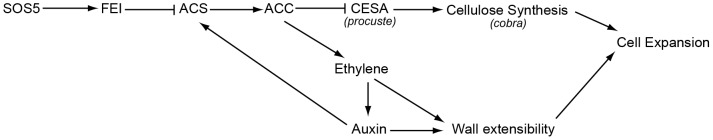
Model of the FEI pathway.Hypothetical model depicting the role of both auxin and the FEI pathway in regulating cell expansion. See text for additional details.